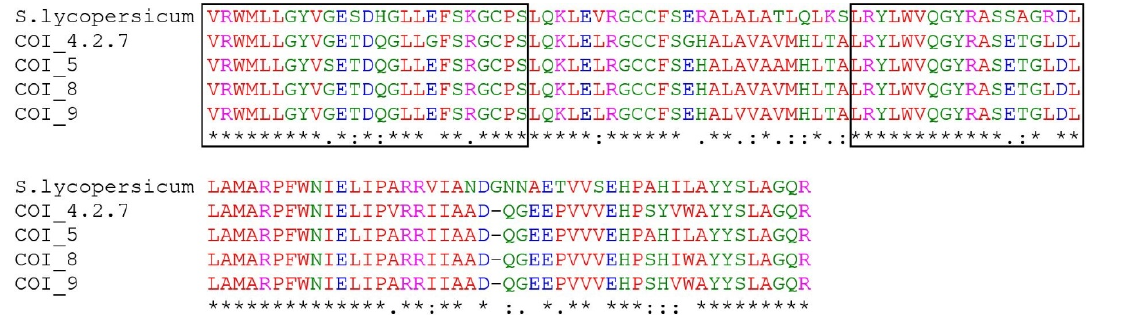
Figure 5. A multiple alignment of four R. nigrum isolates and part of COI1 gene of S. lycopersicum (whole COI1 is 603 amino acids, according to the accession number NP_001234464.1). Sequence part